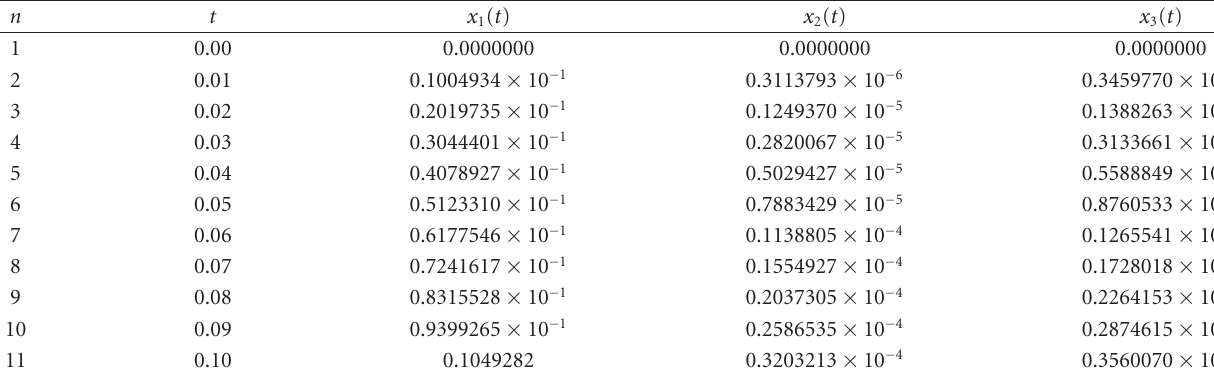
Table 1: Result for sinusoidal